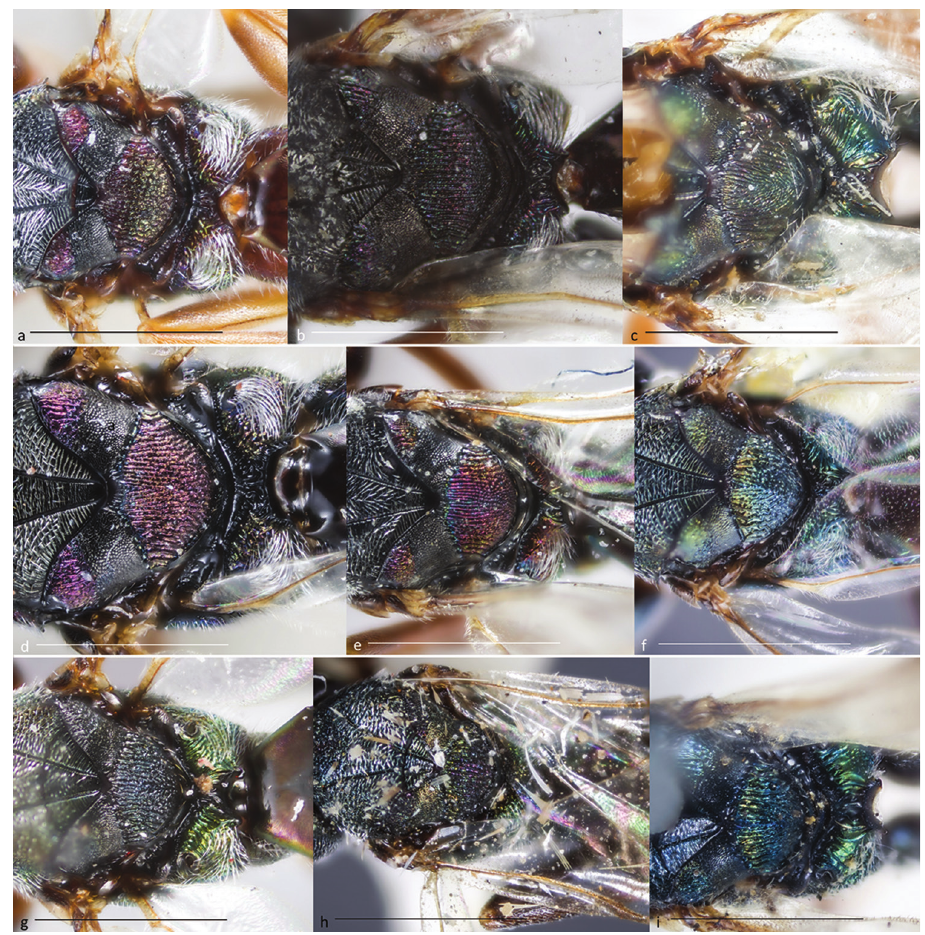
Figure 16. Mesoscutellum and propodeum (dorsal) III a O. magnifica (Risbec) (imaged specimen: OMag01, holotype) b O. mkomaziensis sp. n. (OMk01, holotype) c O. monstrum syn. n. (OFo12, para- type) d O. namibiensis sp. n. (ONa01, holotype) e O. niehuisorum sp. n. (ONi01, holotype) f O. pumilae Yang (OPu01, paratype) g O. regiae Yang (ORe01, paratype) h O. srilankiensis sp. n. (OSr01, holotype) i O. tenuicollis (Walker) (OTe01, holotype). Scale bars: 1 mm.